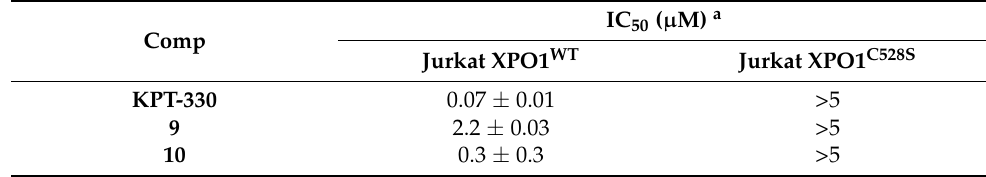
Table 3. IC 50 values of 9 and 10 in means of XPO1 inhibition in wild-type and XPO1 C528S mutant Jurkat cell